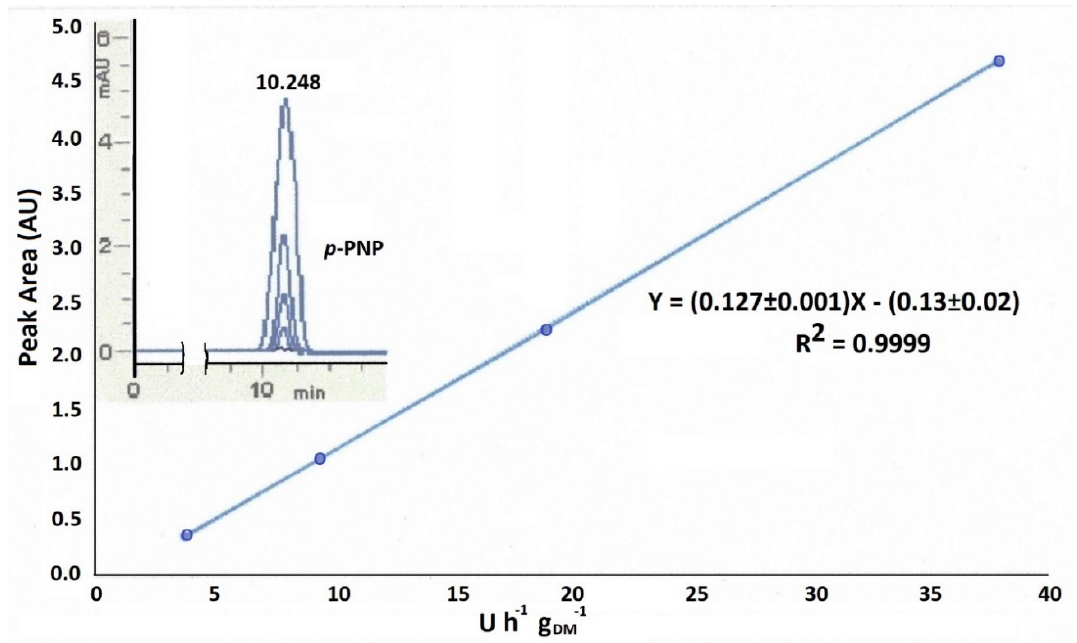
Figure 2. Linear calibration plot of the pNP peaks within the range of enzymatic activity between 3.8 and 38 U h − 1 · g DM − 1 . The inset shows the overlaps of the relevant chromatographic peaks and the blank signal within the same interval of enzymatic activity.